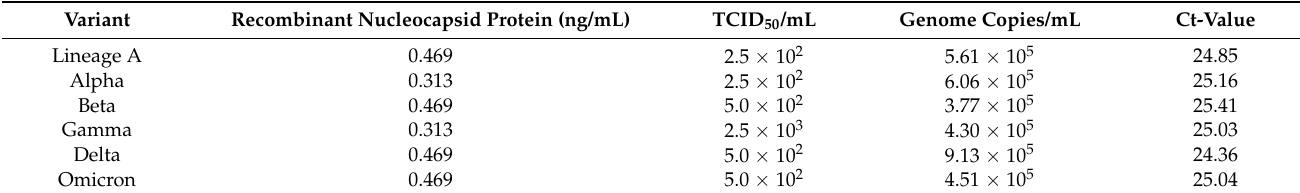
Table 2. InteliSwab ™ limits of detection for SARS-CoV-2